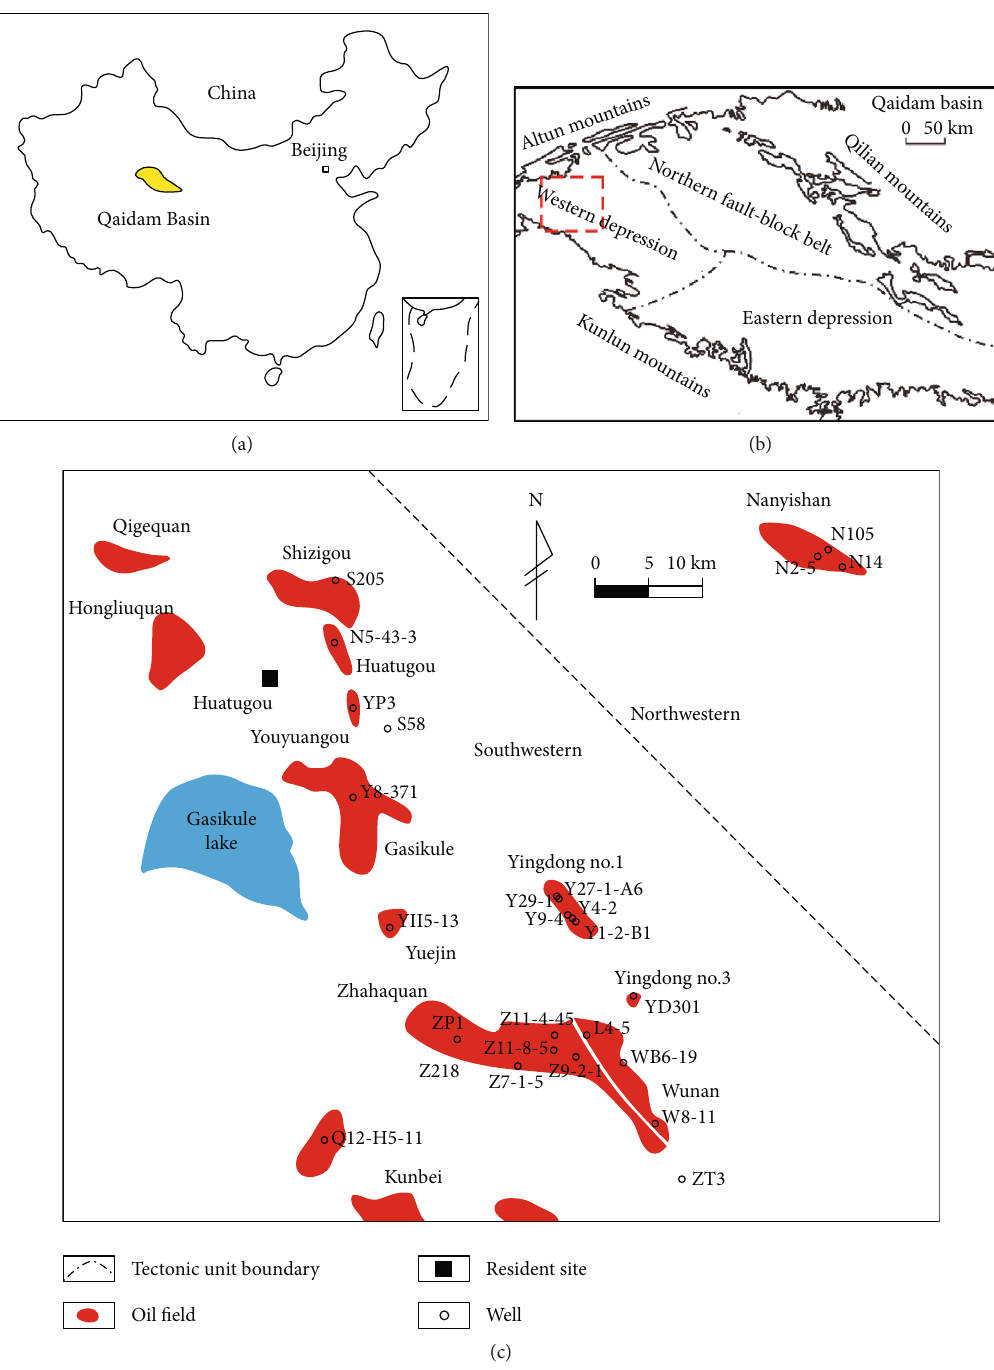
Figure 1: (a) Location of the Qaidam Basin within China; (b) location of three tectonic units in the Qaidam Basin and the rectangle indicates the studied area; (c) distribution of oil fi elds and sample sites and the dashed line is the boundary between southwestern and northwestern Qaidam